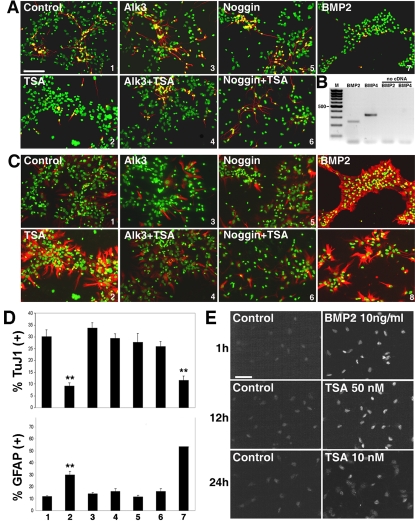
TSA-induced inhibition of neurogenesis from GE-derived precursors is restored by inhibition of the BMP2/4 signaling pathway.(A) Dissociated neurosphere cultures were plated out onto coverslips and treated 1.5 days later with either BMP2 (10 ng/ml), the BMP2/4 inhibitors Alk3-ECD (250 ng/ml) or Noggin (250 ng/ml), alone or in combination with TSA (10 nM). All growth factors, inhibitors, and bFGF were withdrawn 24 hours later. Cells were then cultured for an additional 4.5 days and analyzed by immunofluorescence, staining with the TuJ1 antibody (red) to detect neurons, and DAPI (green) to stain cell nuclei. Scale bar = 100 µm. (B) RT-PCR analysis of Bmp2 and Bmp4 expression in dissociated neurosphere cultures. Control PCR reactions lacking template cDNA are to the right. A 100-bp marker (M) with an indicated 500-bp band is to the left. (C) The identical cultures shown in (A) were stained with an anti-GFAP antibody (red) to detect astrocytes, and DAPI (green) to stain cell nuclei. Panel number 8 shows a culture from a separate experiment in which TSA was withdrawn at 7 DIV after 5 days of treatment and then cultured for an additional 4 days. (A, C) The numbers in the lower right corners of the figures correspond to the numbers beneath the graphs in (D). (D) Mean values +/− SEM (n>5). ** = p<0.01, Mann-Whitney U test. (E) Dissociated neurospheres were plated onto coverslips and were treated with BMP2 (10 ng/ml), or TSA (10 nM or 50 nM) after 1.5 days of in-vitro differentiation, and fixed after 1, 12, and 24 hours. Cells were stained with an antibody recognizing phosphorylated-Smad1/5/8. Displayed here are control conditions (left panels) and treatments (right panels, with indicated compound and concentrations). Scale bar = 50 µm.